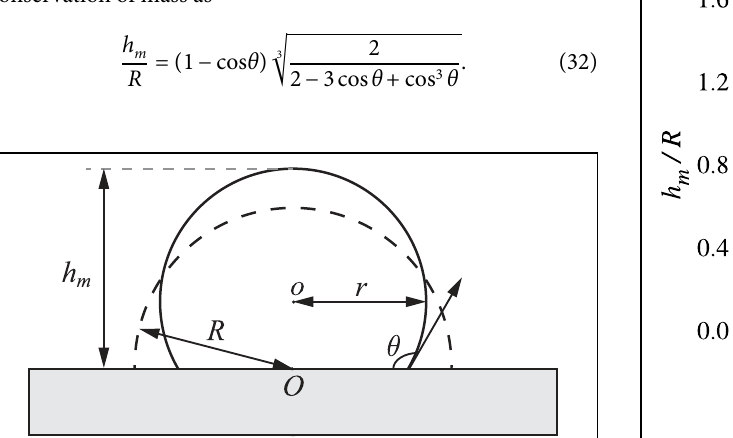
FIGURE 3 | Equilibrium profile and the ratio of h m and R for five different contact